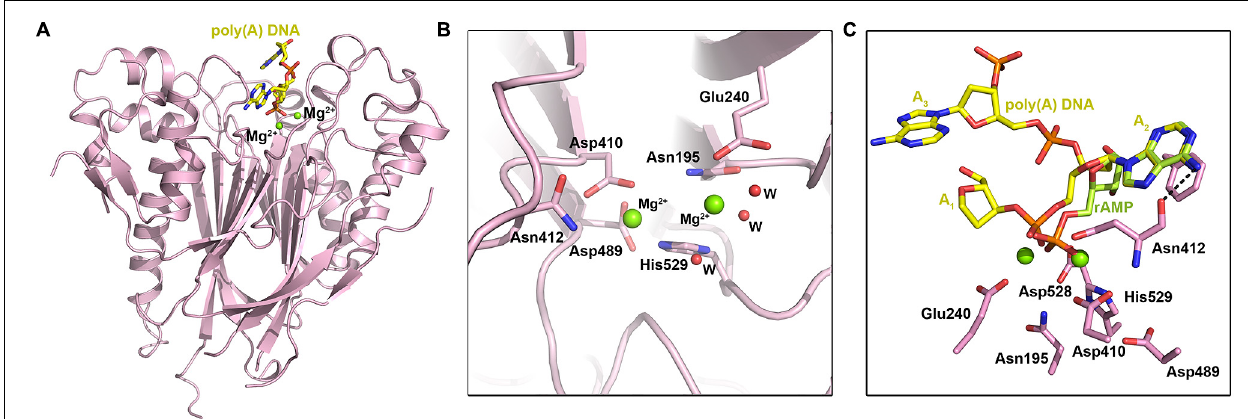
FIGURE 3 |The EEP-type deadenylases. (A) Crystal structure of the human CCR4–NOT nuclease domain in complex with poly(A) DNA (PDB ID: 3NGO). The DNA ligand is shown in yellow stick representation and Mg 2 + ions are shown as spheres. (B) Enlarged view of the human CNOT6L active site showing active site residues in stick representation. Mg 2 + ions are shown as